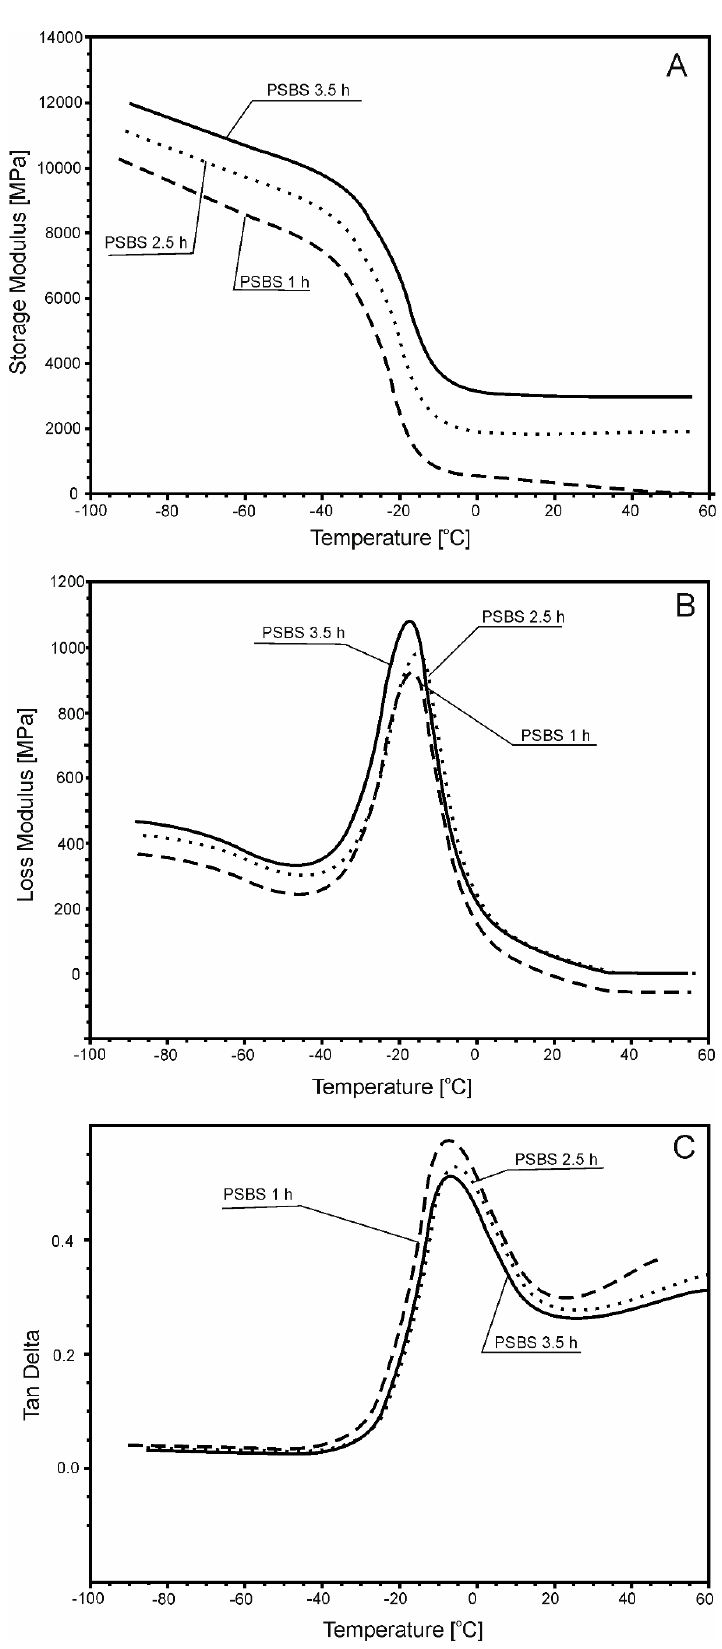
Figure 4. Storage modulus (E’) ( A ), loss modulus (E’’) ( B ) and loss tangent (tan delta versus temperature) (C) for PSBS 1 h, PSBS 2.5 h and PSBS 3.5 h.